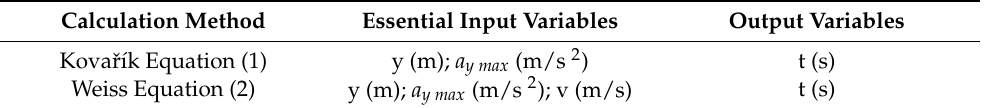
Table 1. Relevant variables of selected empirical